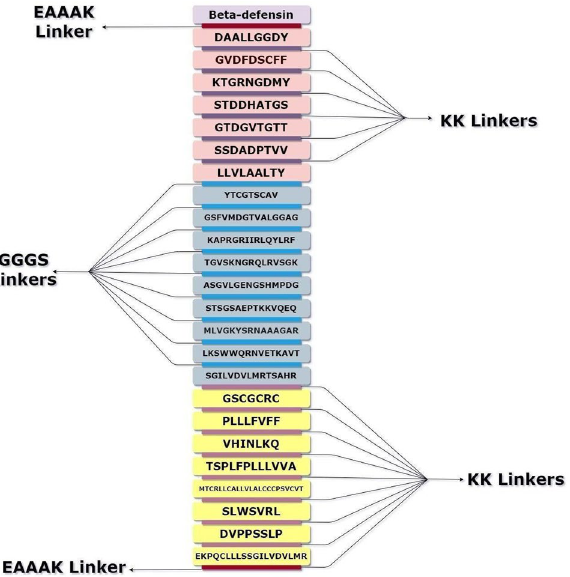
Figure 6. Multi-epitope vaccine constructs for Chagas disease. The vaccine construct consists of 24 epitope sequences, belonging to CTL, HTL and BCL epitopes of 8 T. cruzi proteins. Beta-defensin (Light purple) was used as the adjuvant and is linked to the top CTL epitope (light pink) using an EAAAK (maroon) linker. The other CTL epitopes were linked to each other using GGGS (violet) linkers. The last CTL epitope and the first HTL epitope (blue), as well as the other HTL epitopes were connected through an AAY (sky blue) linker. The last HTL epitope and the first BCL epitope (yellow) as well as the other BCL epitopes were connected through a KK (purple) linker. An EAAAK (maroon) linker was added at the end of the sequence for increasing stability (Draw.io—https:// www. diagr ams. net/- 14.6. 10).